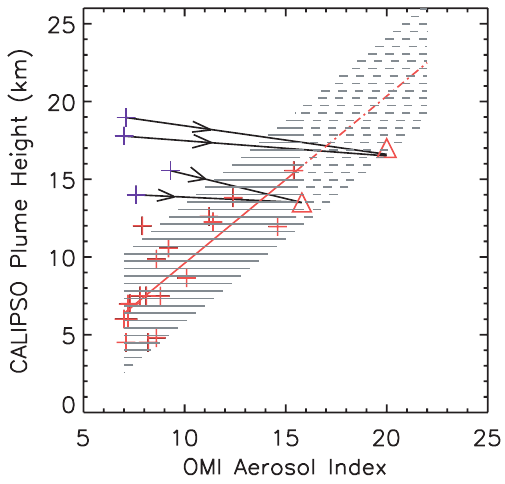
Fig. 4. Scatter-plot of OMI AI and CALIPSO maximum plume height. Red and blue symbols represent “young” and “aged” plumes, respectively, as described in Fig. 3. Solid shaded area shows ± 2 standard deviation (2-sigma ≈ 3.8km) across the best fit of the young plumes indicated by red crosses. The young-plume data in red triangles were inferred from forward trajectory model calculations and OMI observations 3 or 4 days before the obser- vations (blue crosses). The four aged plumes (4–5 days old) were inside or near the dash shaded area (2-sigma) when they were young (1 day